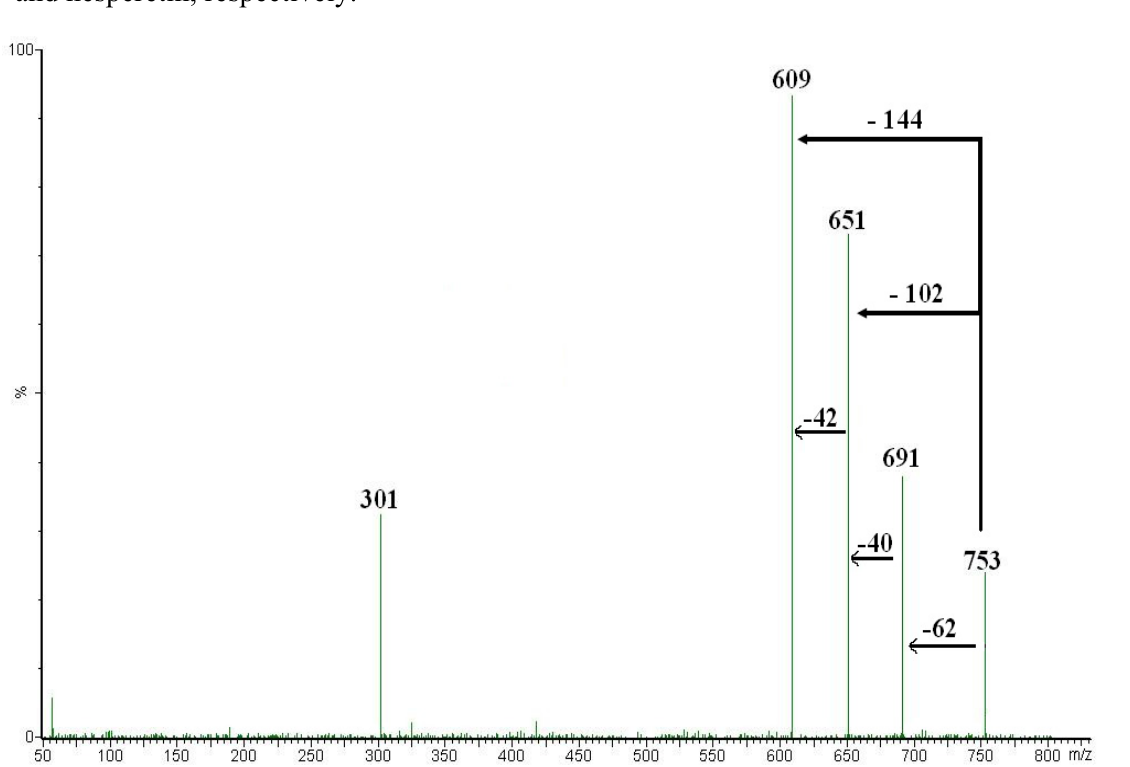
Figure 3. Fragmentation pattern of the peak 7 (MW 754) obtained at lower collision energy. The ions product with (m/z) - 609 Da and (m/z) - 301 Da correspond to hesperidin and hesperetin,